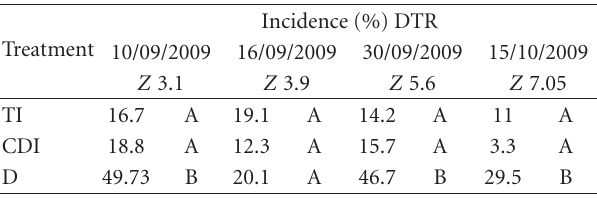
Table 5: 1000 grains weight, biomass of harvested grain (BHG) and index harvest (HI) measured during 2009 for total irrigation (TI), irrigation with controlled deficit (CDI) and dry (D)